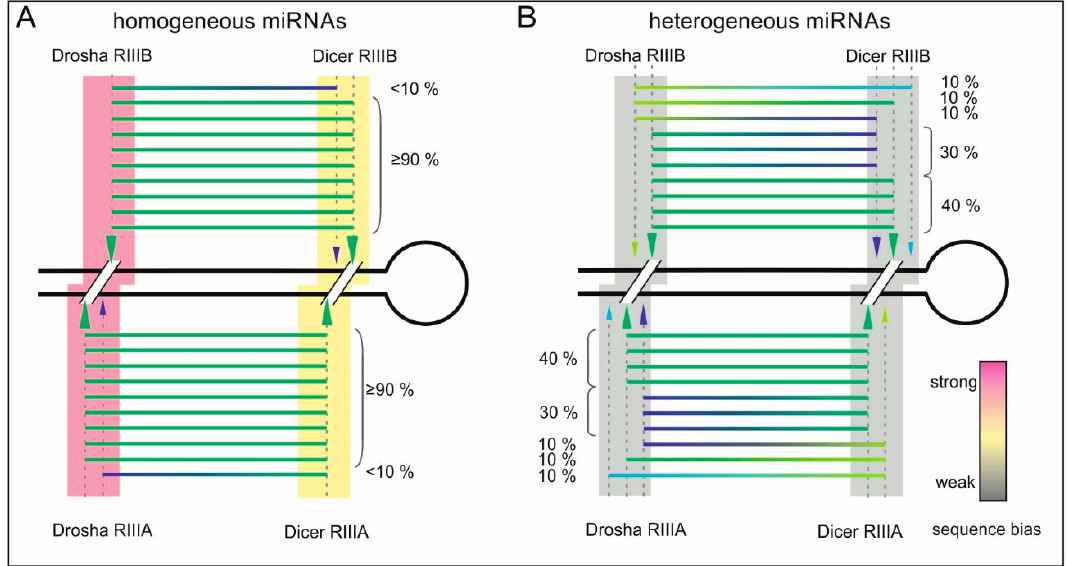
Figure 4. Schematic representation of the pool of isomiRs released from ( A ) homogeneously and ( B ) heterogeneously processed pri-miRNAs. The cleavage sites of the Drosha and Dicer RNase domains (RIIIA and RIIIB) are indicated with arrowheads whose size corresponds to the intensity of cleavage at these positions. The background colors at different cleavage sites indicate the occurrence of sequence bias at these sites, which affects the generation of homogeneous and heterogeneous miRNAs (according to the